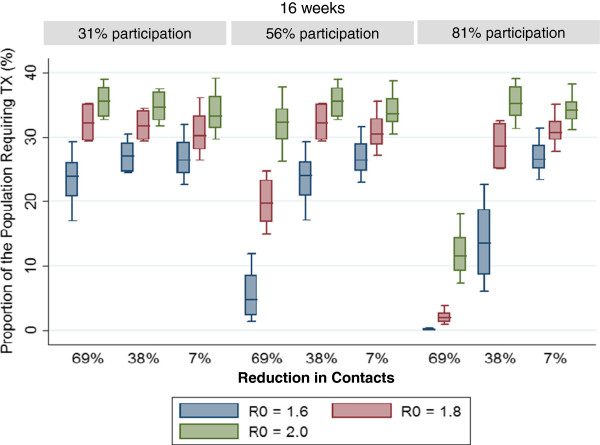
The median (line within the shaded box), 25th and 75th percentile values (top and bottom of shaded box), and upper and lower adjacent values (error bars) proportion of the Canadian population expected to require antiviral treatment (Y-axis) during a severe pandemic as a function of viral transmissibility and the magnitude of change maintained for 16 weeks. Each box represents 9 individual simulation runs using a range of pre-existing immunity values from 0-40%. We examined three different levels of behaviour change uptake where between 31% and 81% of the Canadian population engages in social distancing behaviour. The magnitude of the behaviour change ranged from only a 7% reduction in contacts to a 69% reduction in contacts for all scenarios.